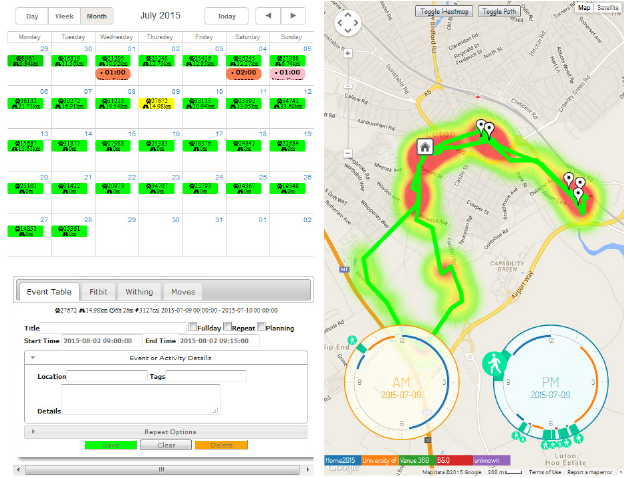
Figure 7 Integrated view of diary, map and clock